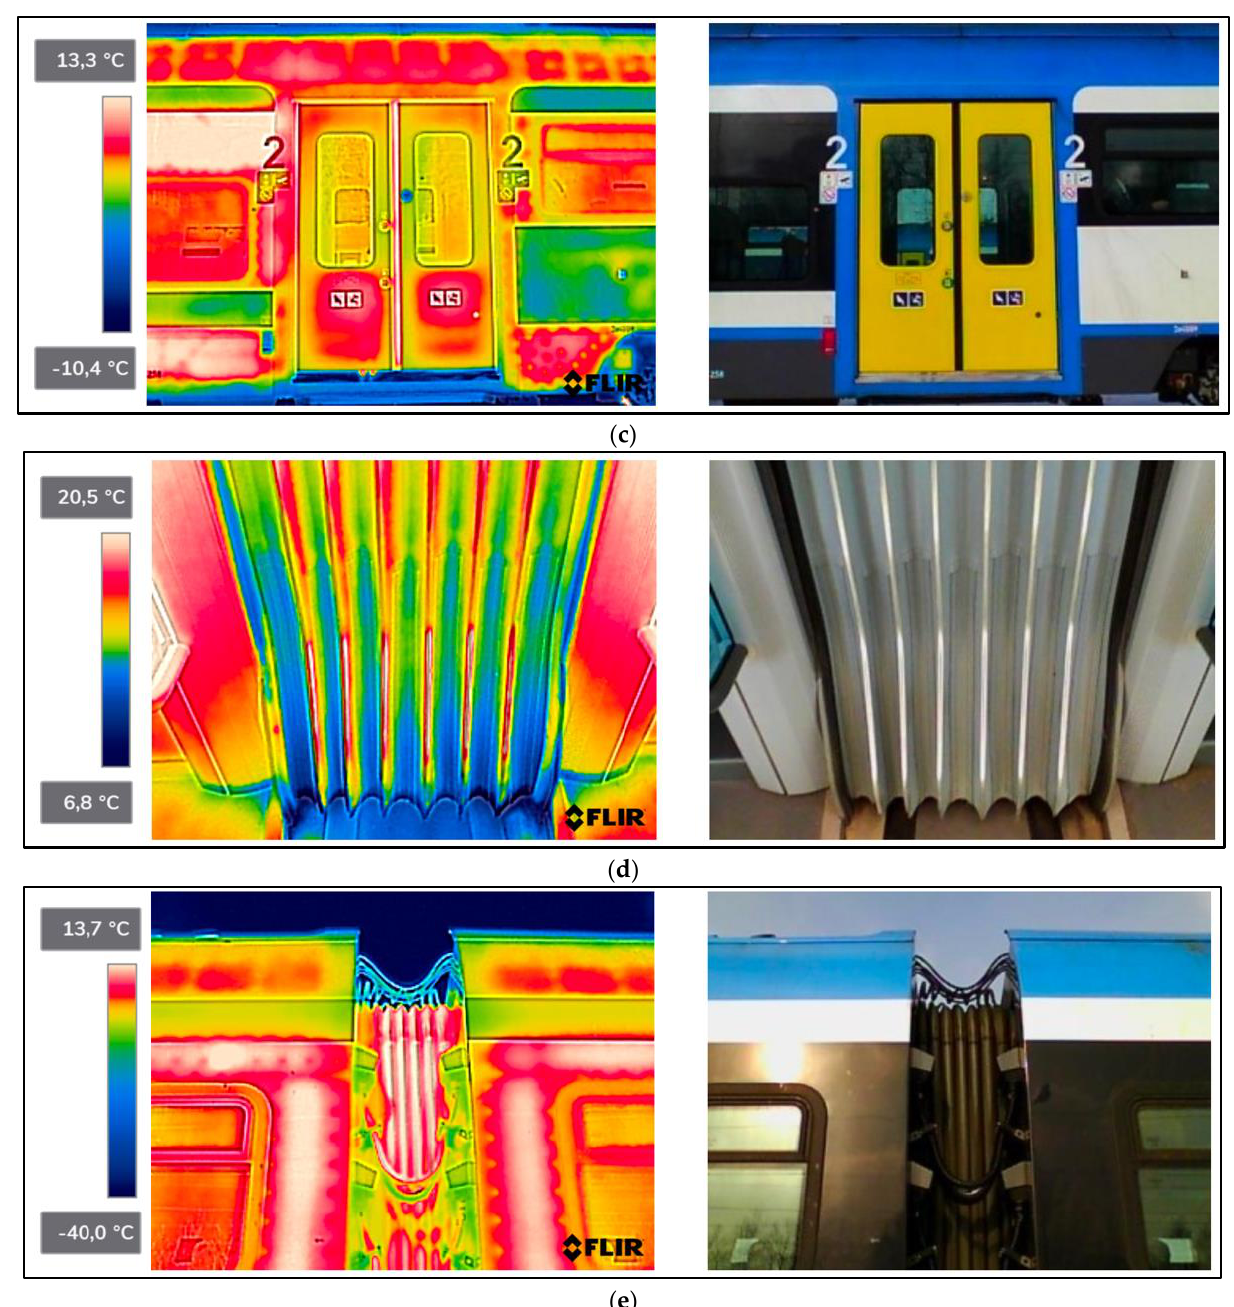
Figure 2. 21WEa-003 − thermogram of critical components of the railway vehicle: ( a ) door − upper part from inside the vehicle; ( b ) door − lower part from inside the vehicle; ( c ) door from outside the vehicle; ( d ) interconnection from inside the vehicle; ( e ) interconnection from outside the vehicle.